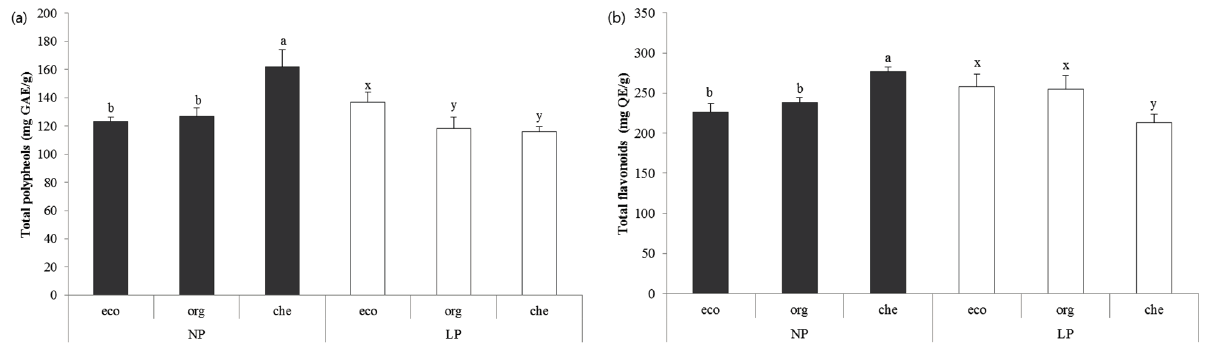
Figure 1. ( a ) Total polyphenol content of chicory; ( b ) Total flavonoid content of